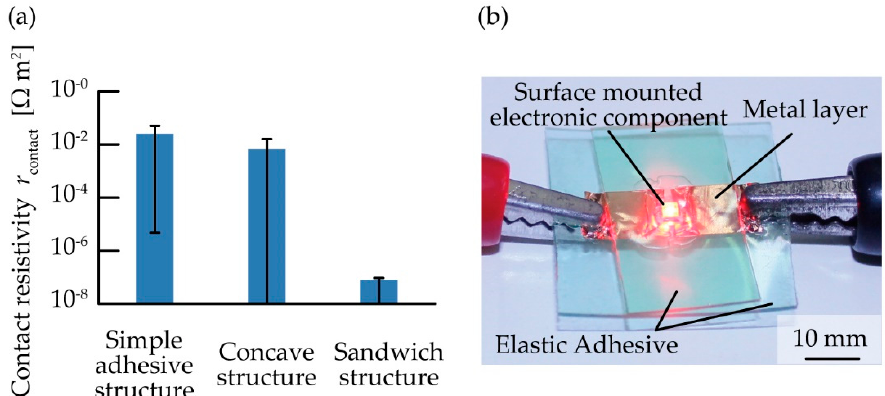
Figure 8. ( a ) Comparison of contact resistivity values in simple adhesive, concave, and sandwich structures; ( b ) flexible electronic device with light emitting diode (LED) chip mounted on a sandwich structure.